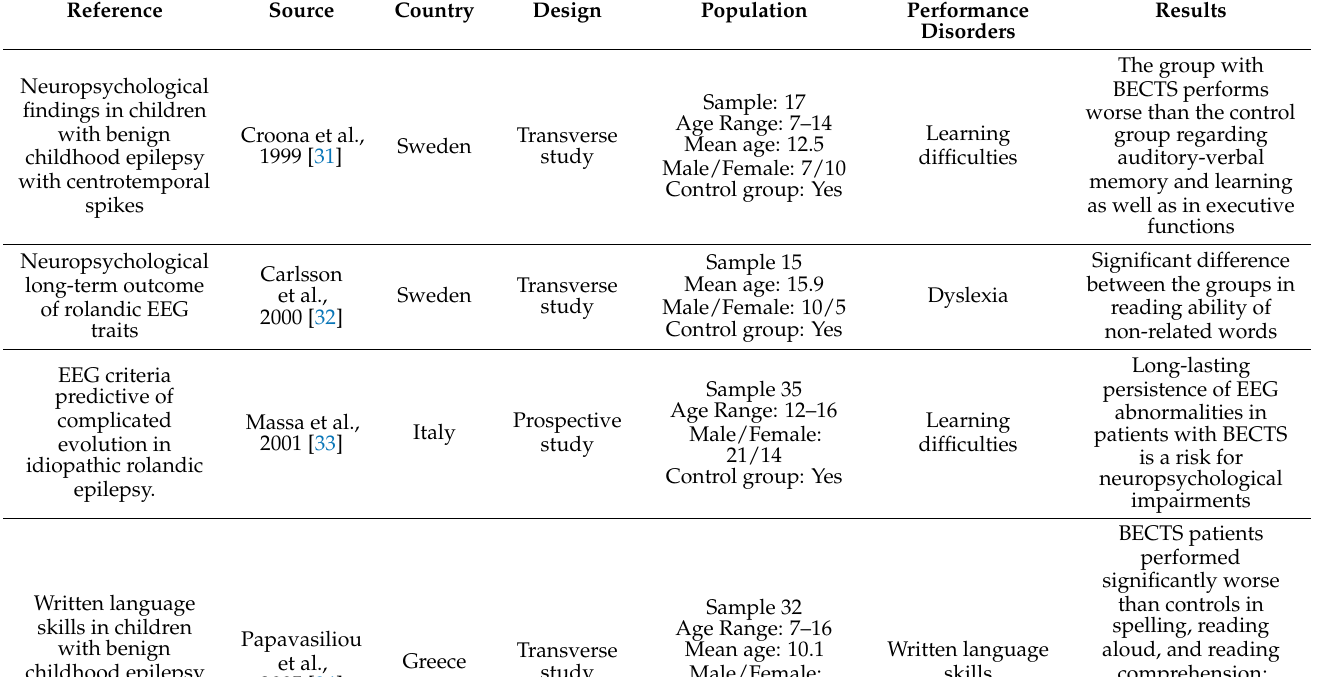
Table 1. Analyzed studies assessing academic performance disorders in children with